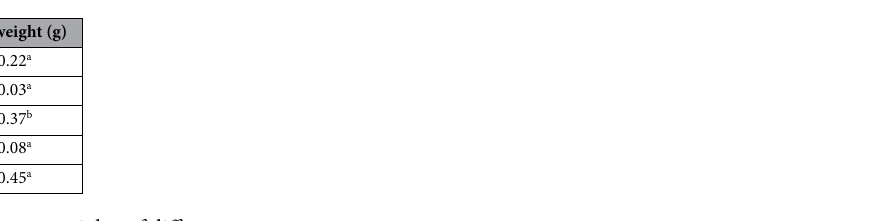
Table 4. Liver organ weights of different